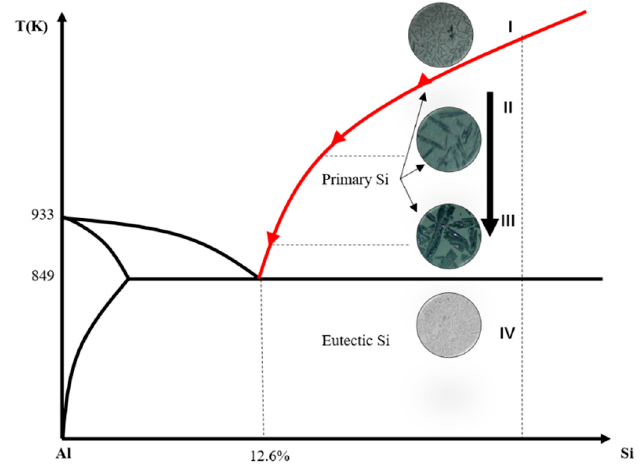
Figure 7. Segregation process of the impurities during Czochralski (Cz) process.